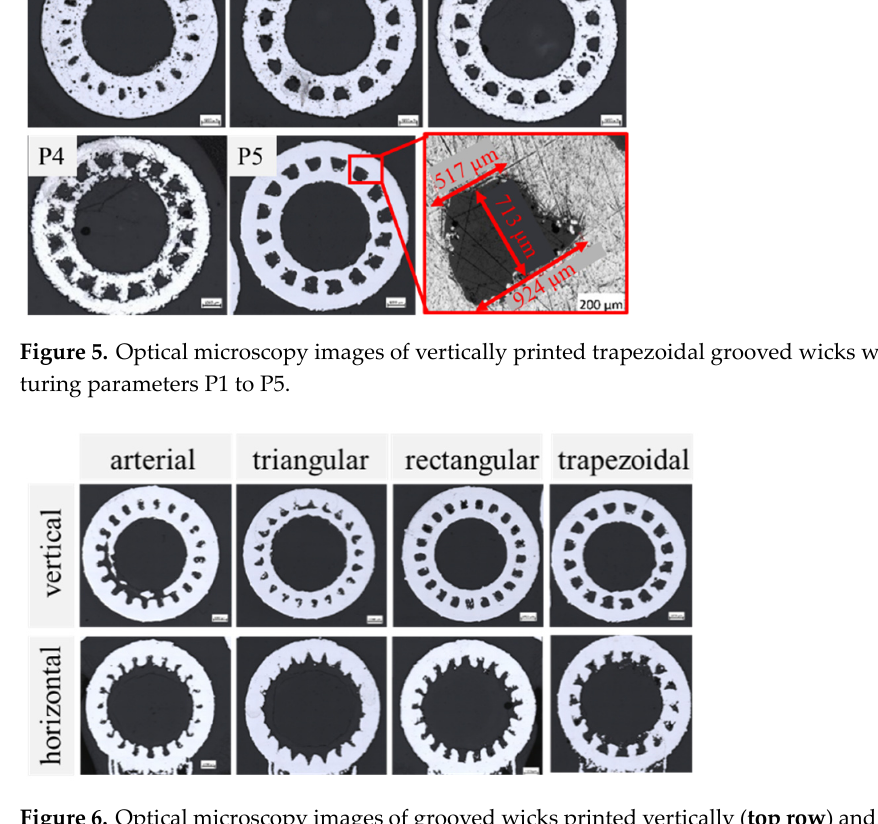
Figure 5. Optical microscopy images of vertically printed trapezoidal grooved wicks with manufac- turing parameters P1 to P5.